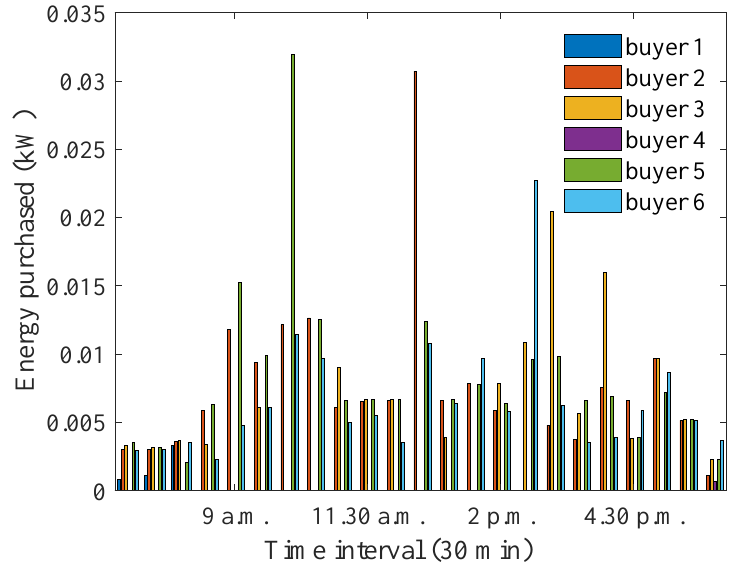
Figure 17. Optimum energy purchased when distance between house 1 and the aggregator is increased.